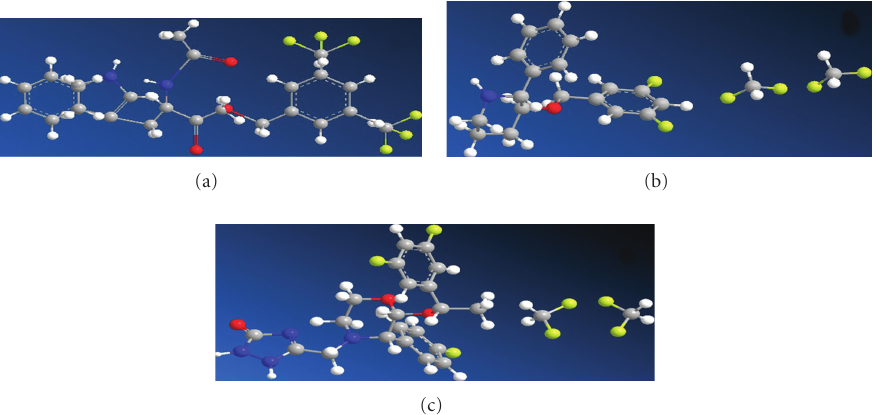
Figure 4: The chemical structure is shown for L-732,138 (a), L-733,060 (b), and aprepitant (c). Hydrogen elements are symbolized in white, carbon in grey, nitrogen in blue, oxygen in red, and fluorine in yellow